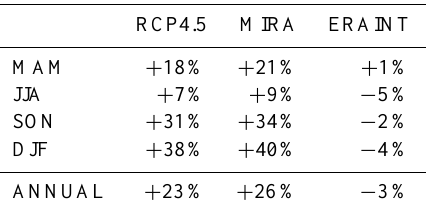
Table 3. Overview of the 10-year mean differences in surface O 3 concentrations compared to the Reference scenario over